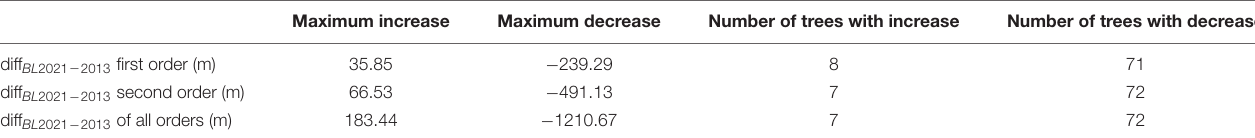
FIGURE 5 | Change in the total branch length between winter 2013 and winter 2021 (diff BL 2021 - 2013 ) for each height percent on plot level for the analyzed branch orders one (A) , two (B) , and all orders combined (C) . The vertical dotted line represents zero change in the total of branch length per height class. TABLE 3 | Maximum increase and decrease in branch lengths on single tree basis between winter 2013 and winter 2021, as well as number of trees showing an increase and a decrease of the orders one, two, and all order combined for a total of 79 observations. Maximum increase Maximum decrease Number of trees with increase Number of trees with